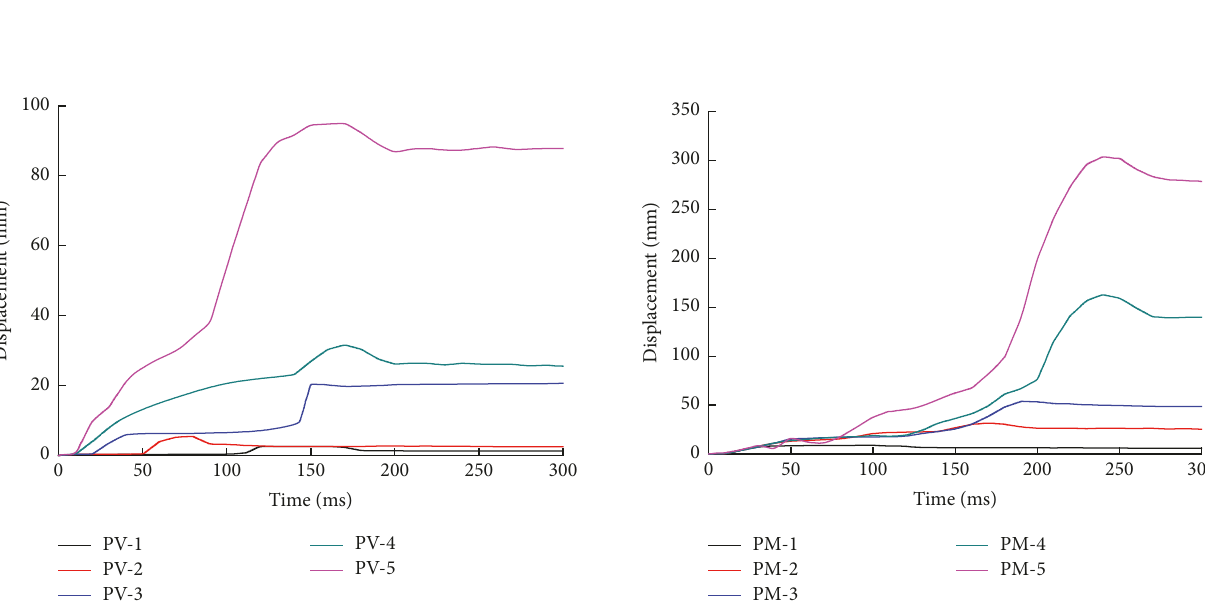
Figure17:Displacementtime-historycurvesunderdifferentimpact velocities.